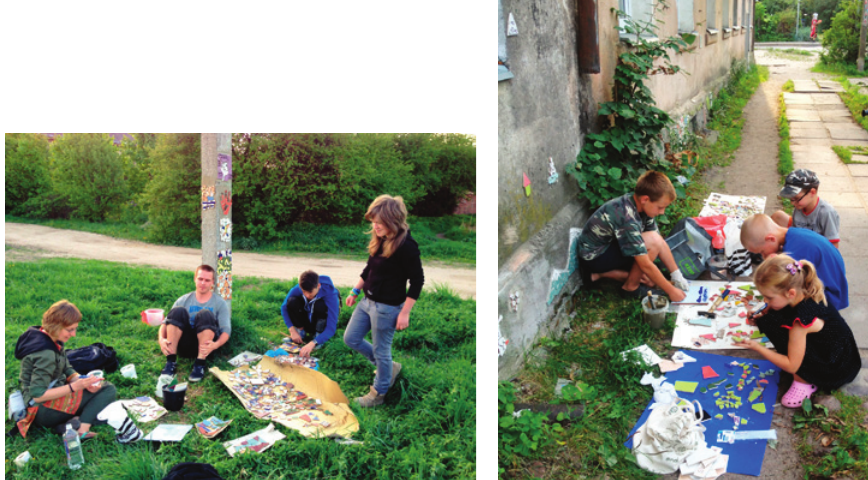
Figs 4a, 4b. A format of Street Mosaic Workshop is open: everyone can join. While the most enthusiastic participants of Street Mosaic Workshop were youngsters and children, who took part in the creation of the mosaics, the elderly supported the initiative by donating tiles, commenting and inviting to decorate their houses. Illustration by Tomas